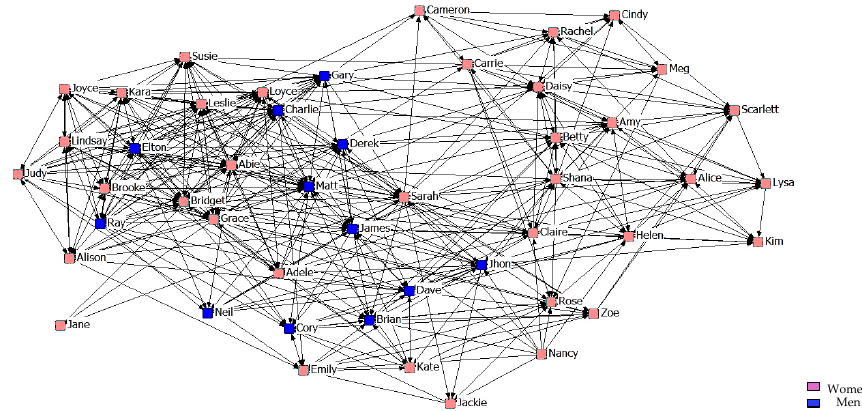
Figure 1. Graph of the first year Support Network.